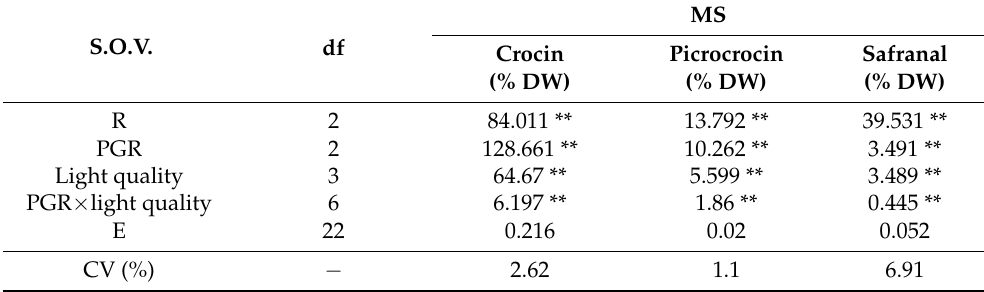
Table 2. Analysis of variance for the effect of treatments on phytochemical traits of saffron. S.O.V.